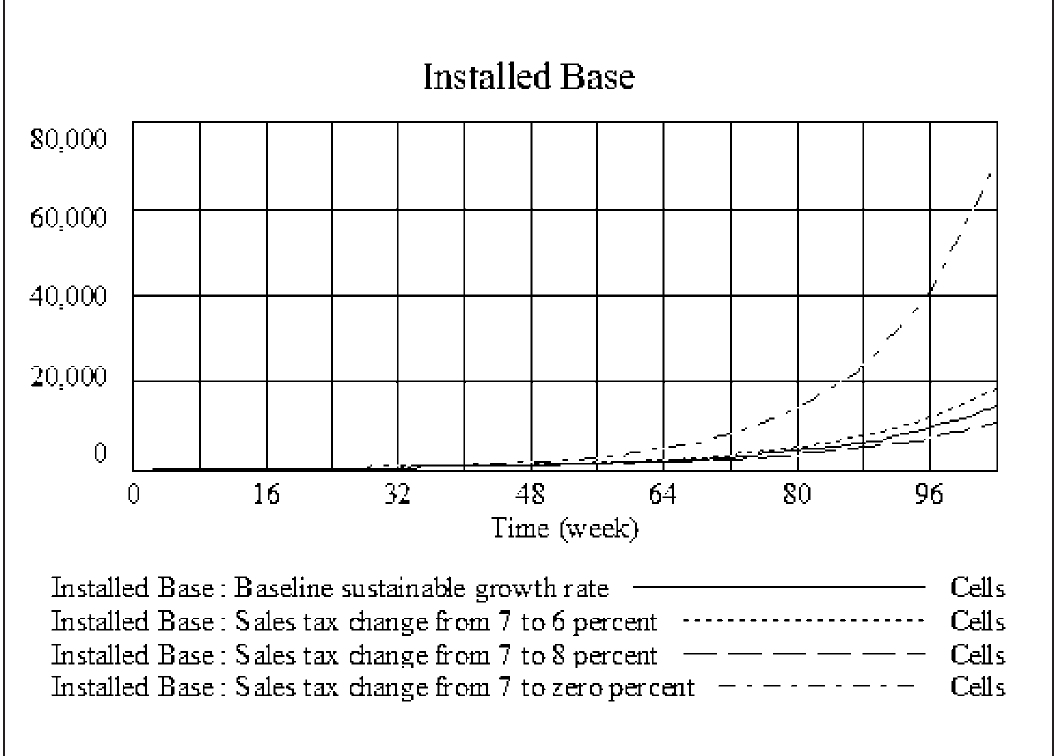
Figure 12. Cumulative Sales and Installed